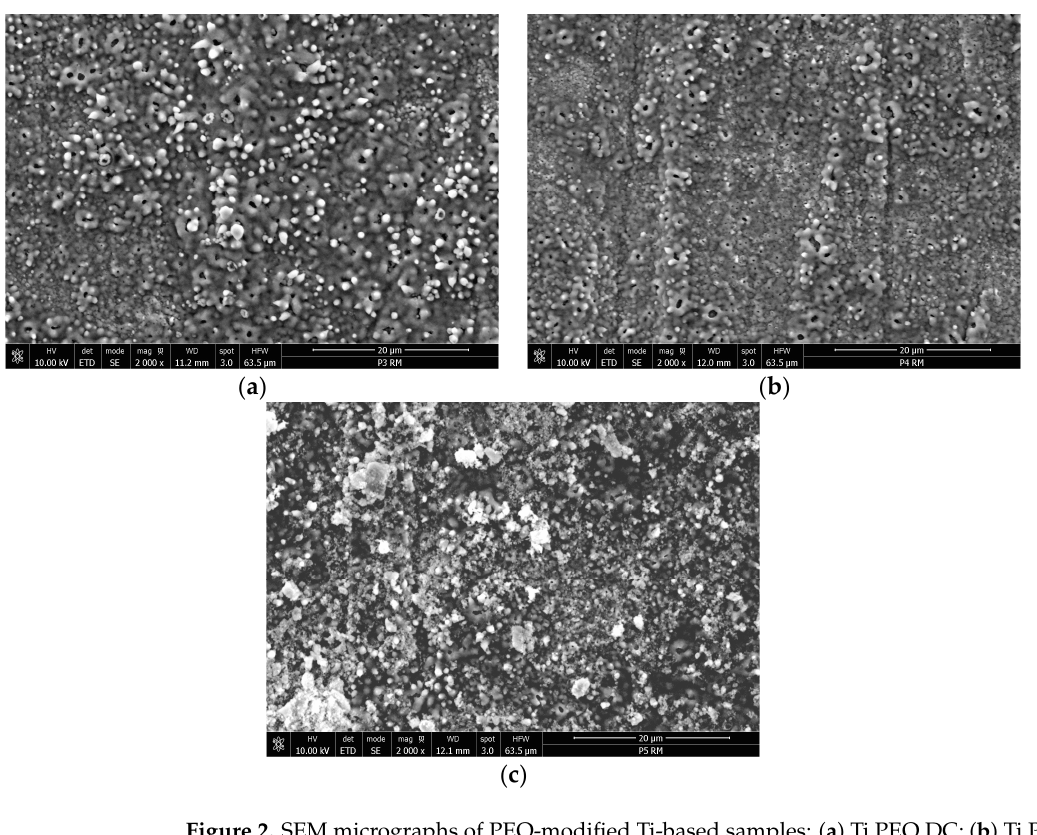
Figure 2. SEM micrographs of PEO-modified Ti-based samples: ( a ) Ti PEO DC; ( b ) Ti PEO PC; ( c ) Ti PEO PC + HAP.